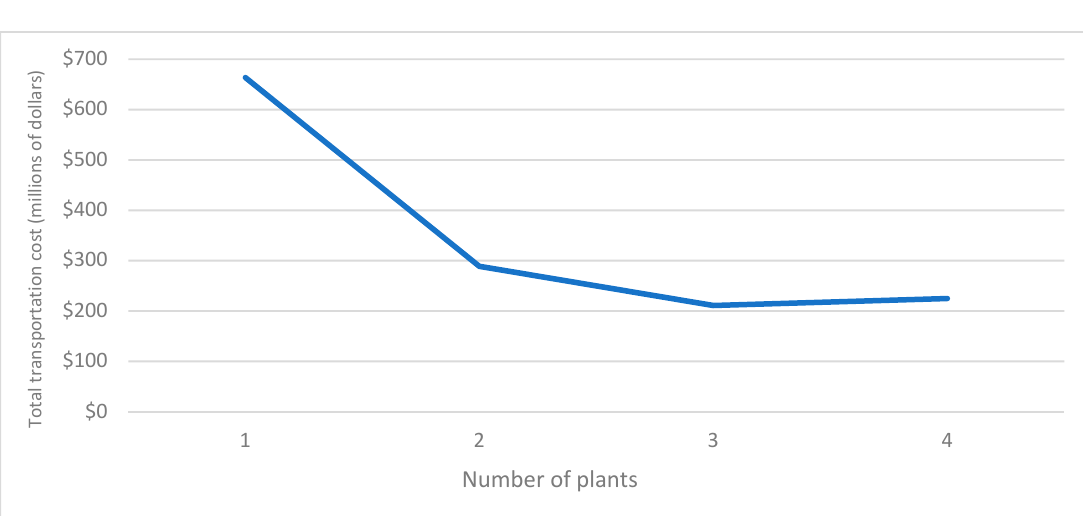
Table 4. Estimated transportation cost of biomass feedstock.